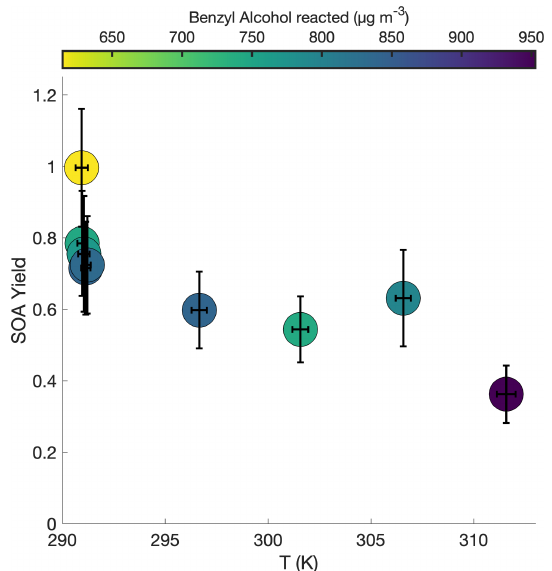
Figure 5. Variation in SOA yield over several hours of benzyl alco- hol oxidation as a function of temperature with an initial NO mixing ratio of 72 to 81ppb as a function of the amount of benzyl alcohol reacted for experiments R1–R3 and T1–T4. The color is propor- tional to the amount of benzyl alcohol that has reacted at the end of the experiment. Experiments began with between 78 and 102ppb of benzyl alcohol and initial seed surface area concentrations of 1800 to 2900µm 2 cm − 3 . Error bars are given for the yields at the end of each experiment (experiment lengths are given in Table 1).